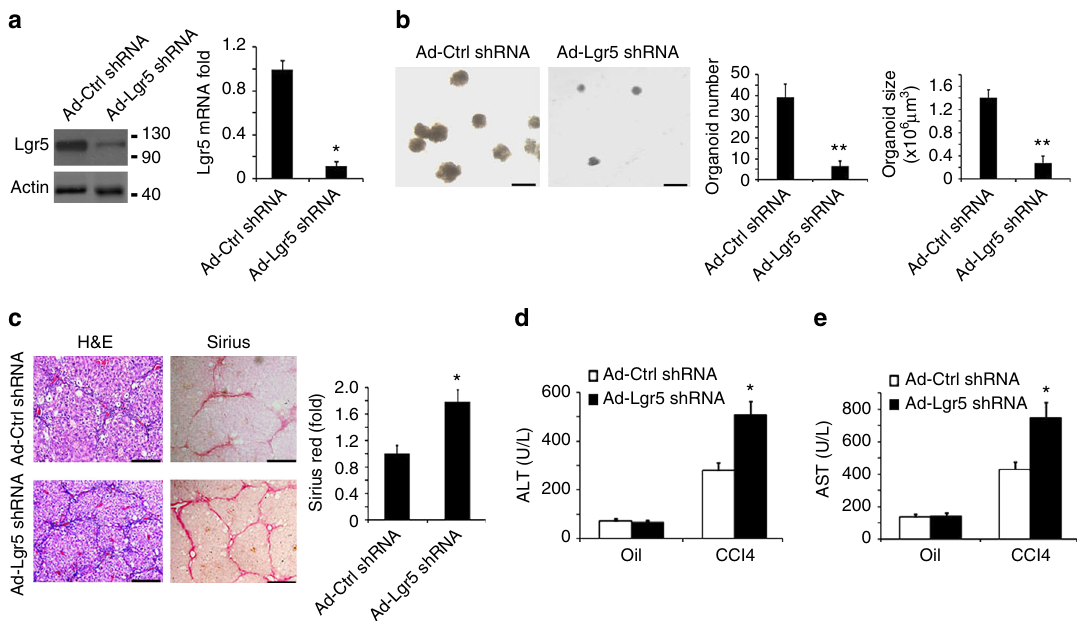
Fig. 2 Knocking down of Lgr5 expression decreases Lgr5 + cells ’ stem cell properties and increases liver fi brosis. a Lgr5 was knocked down by Ad-Lgr5 shRNA. Lgr5 + liver stem cells were isolated and infected with Ad-Lgr5 shRNA, or nonsense control shRNA Ad-Ctrl shRNA, western blot, and qRT-PCR were used to analyze the proteins level (left) and the mRNA level (right) of Lgr5. Actin was used as a loading control. b Lgr5 + liver stem cells failed to form an organoid when Lgr5 was downregulated by Ad-Lgr5 shRNA. Lgr5 + liver stem cells were isolated and infected with Ad-Lgr5 shRNA or Ad-Ctrl shRNA, and cultured in stem cells medium in Matrigel, and the number and sizes of the liver organoid were measured at day 14. b – e Ad-Lgr5 shRNA increased CCL4-induced liver fi brosis. As shown in Supplementary Fig. 10a, Lgr5-GFP mice infected with Ad-Lgr5 shRNA or Ad-Ctrl shRNA were administered with CCL4 (2 ml/kg i.p.) twice/week for 6 weeks, respectively. The representative histology of H&E and Sirius Red, and the quanti fi cation of positive-staining areas is measured by Image J software ( c ). Serum levels of ALT and AST were measured ( d , e ). For a , d , e , triplicates for each condition were analyzed. The results are shown as mean ± s.d. of three independent experiments. * p < 0.05. For b , the results are shown as mean ± s.d. of three independent experiments. ** p < 0.01. For c , scale bars, 200 μ m, the results are shown as mean ± s.d. of fi ve independent sections taken randomly per mice and a total of 50 tissue specimens in each group ( n = 10 mice), * p <